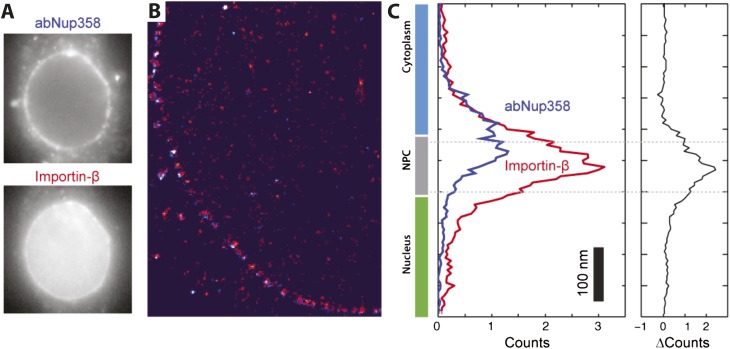
Two color STORM imaging.(A) Widefield imaging of STORM labeled abNup358 and impβ. (B) Two-color STORM showing abNup358 labeled in blue and impβ labeled in red. The antibody again Nup358 localizes toward the cytoplasmic face of each NPC structure. The image is undersampled due to activation cross-talk problems outlined in the discussion. (C) Histogram of average counts for abNup358 and impβ localizations, showing the cytoplasmic bias in position of abNup358. The difference between the two distributions is found mainly in the NPC channel.